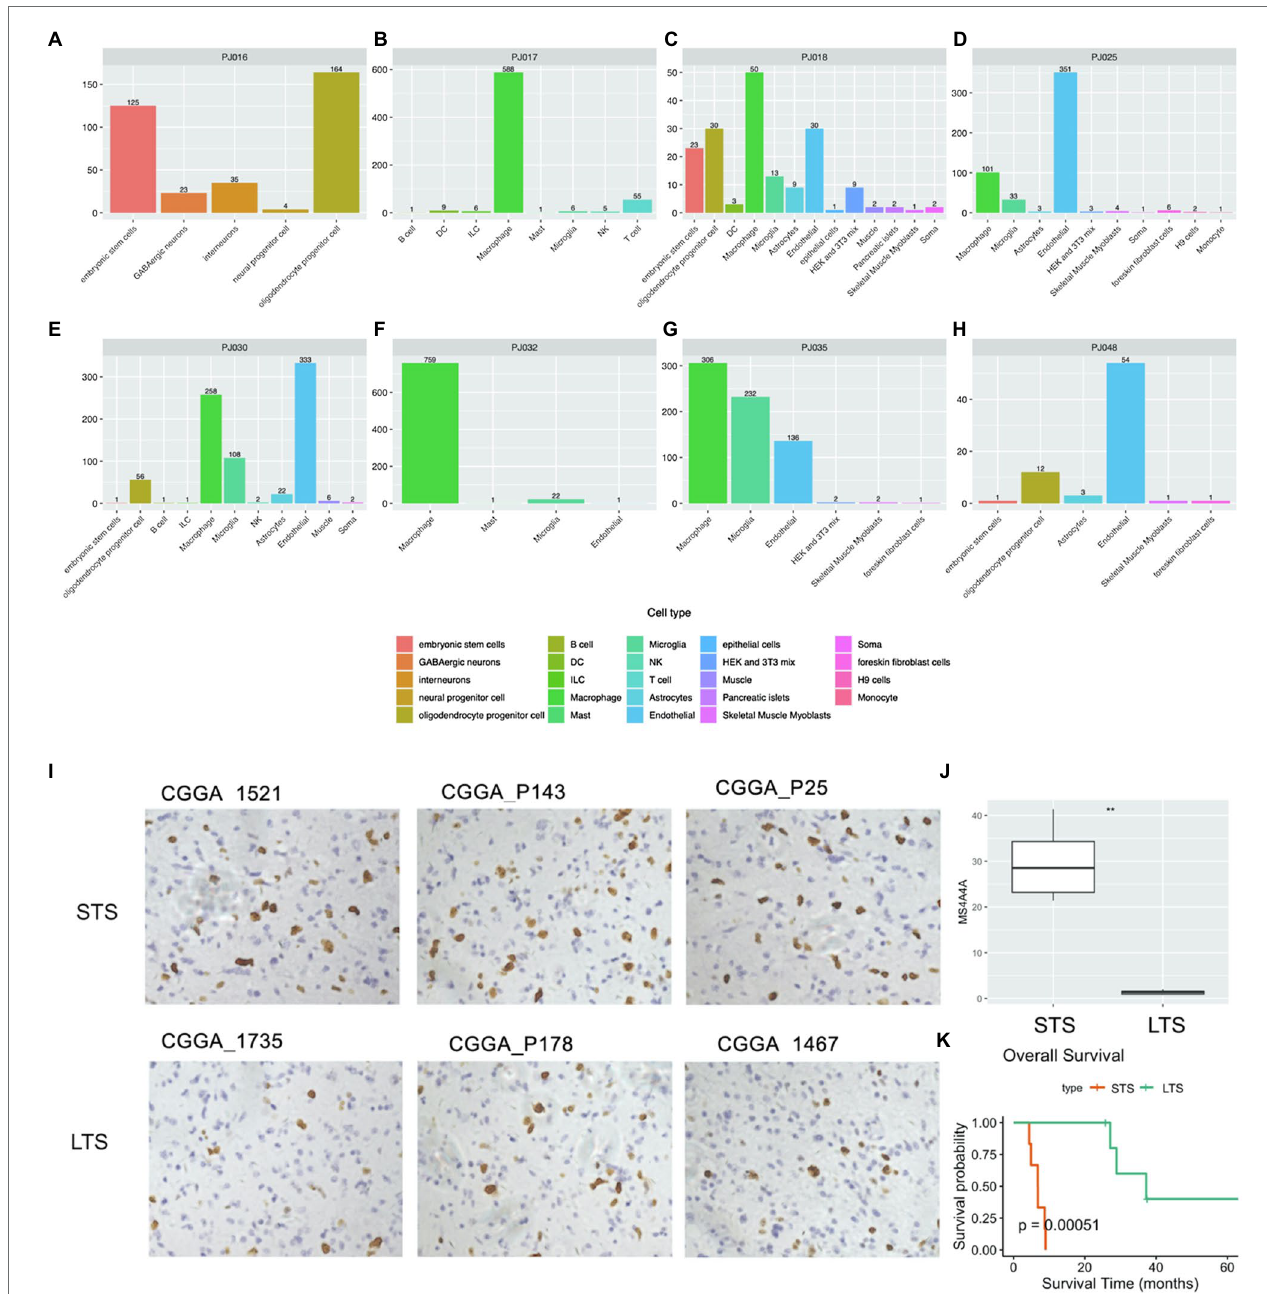
FIGURE 5 | Cell type analysis using scRNA-seq data. (A–H) Cell type counts in scRNA-seq samples. (I) IHC staining of macrophages (NIR samples, upper; PIR samples, bottom). (J) Percentage of macrophages in NIR and PIR samples (according to staining for MS4A4A; scale bar: 100 μ m). (K) Kaplan–Meier survival curves of NIR and PIR samples. IHC, immunohistochemical; LTS, long-term survival; NIR, negative immune response; PIR, positive immune response; scRNA, single-cell RNA; and STS, short-term